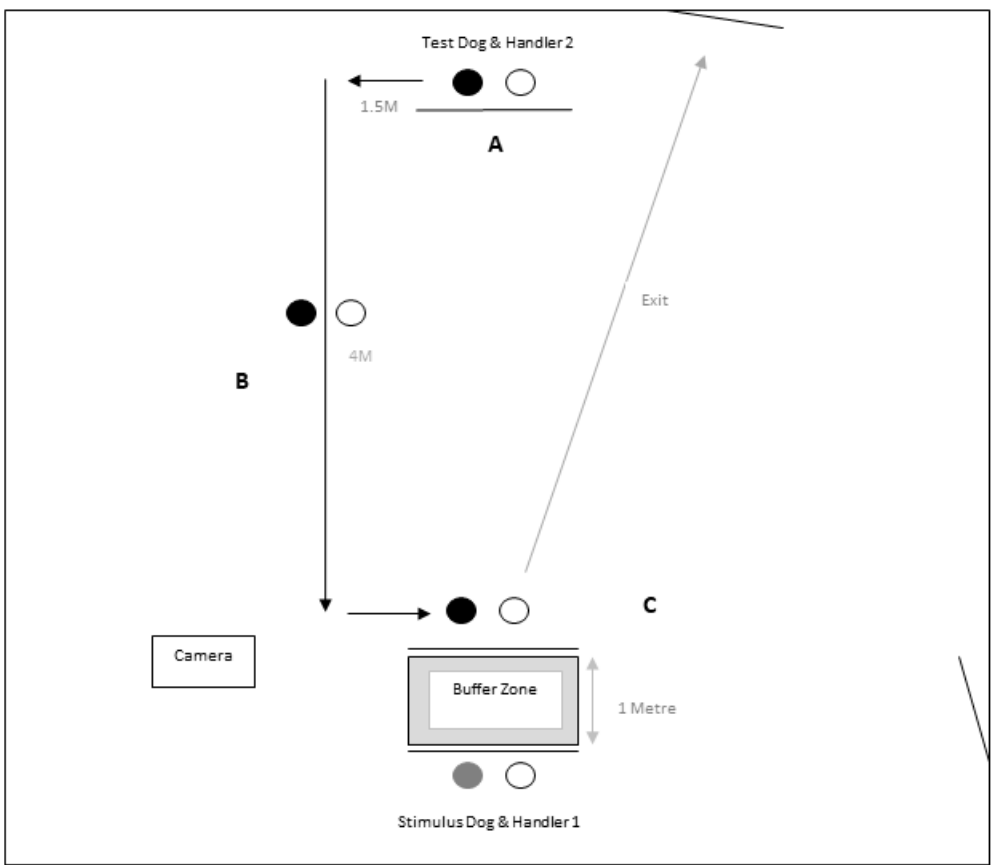
Figure 1. Procedure for dog-dog interaction subtest. Solid circle = handlers, white circle = dogs. Letters indicate the three phases of the protocol: A = distance, B = approach, and C = proximity.